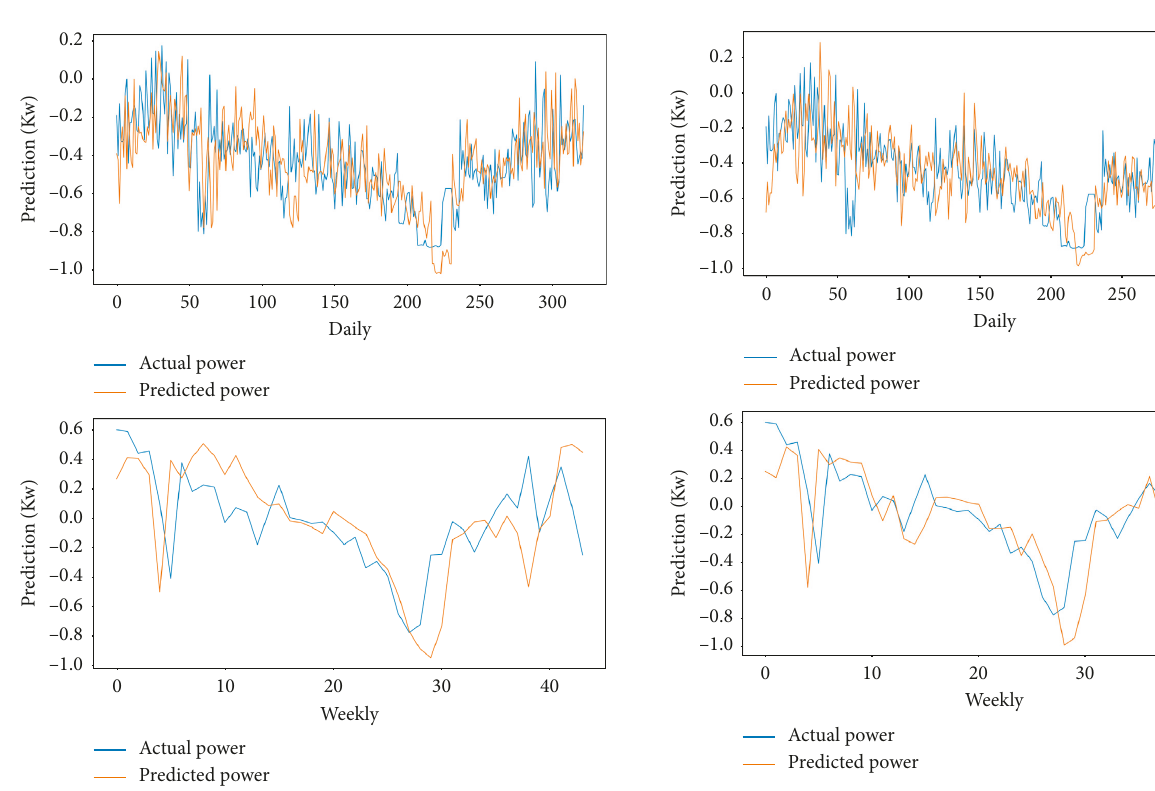
Figure 8: Visual representation of ED-GRU-based forecasting results considering daily and weekly horizons on the household power dataset.